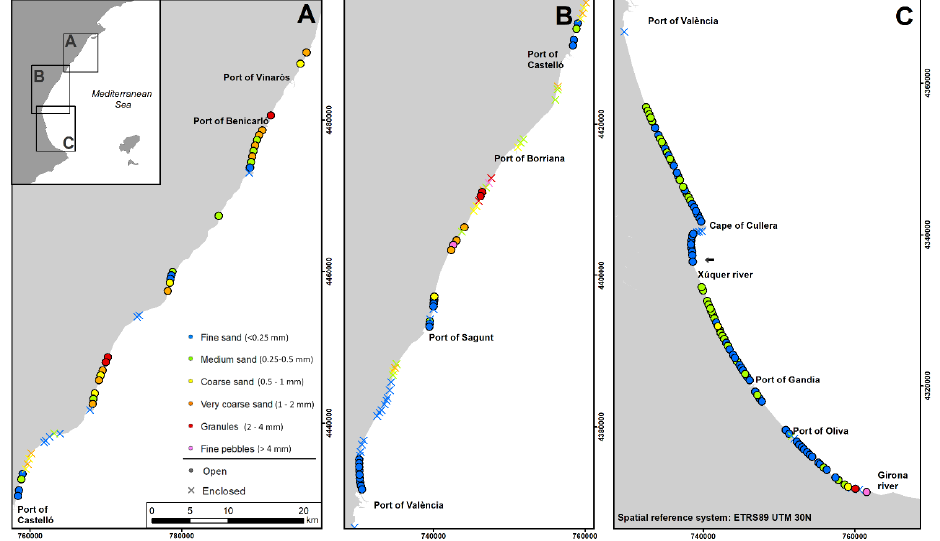
Figure 3. Sampling locations along the Gulf of Valencia, which appears divided from north to south in three sectors ( A – C ). Grain sizes of the beaches (as D 50 ) are represented by different colors and the morphological classification by symbols (circles and crosses for open and enclosed beaches respectively). The black arrow identifies the site used in Figure 6 for describing the definition of SDS variability.